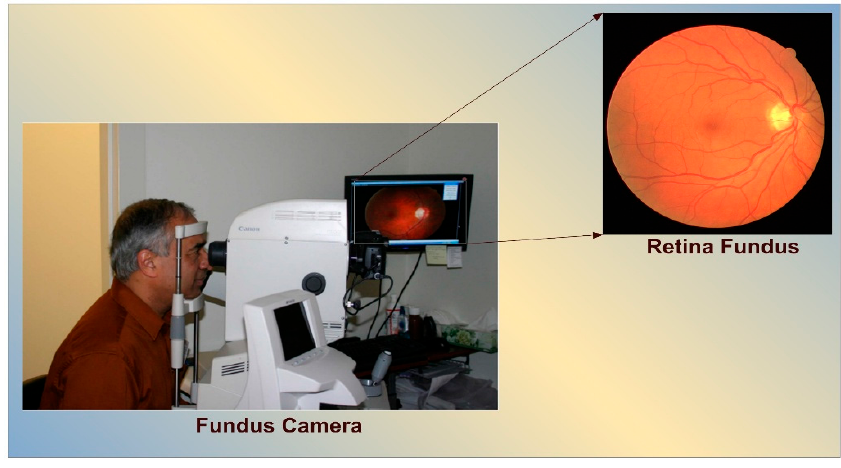
Figure 1. Retinal fundus camera. Adapted with permission from [12], IEEE, 2007.